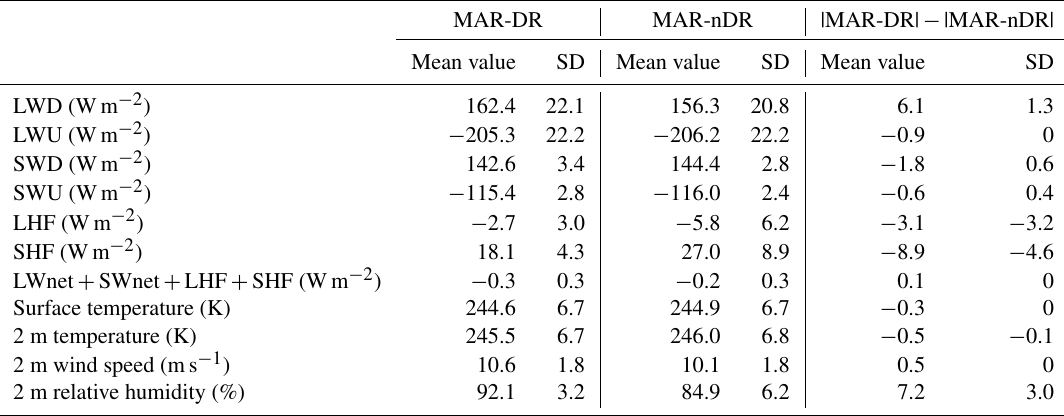
Table 3. Half-hourly mean value and standard deviation (SD) for several near-surface and surface meteorological variables computed on Adelie Land with MAR-DR and MAR-nDR. Differences between both model runs are attributed to drifting-snow